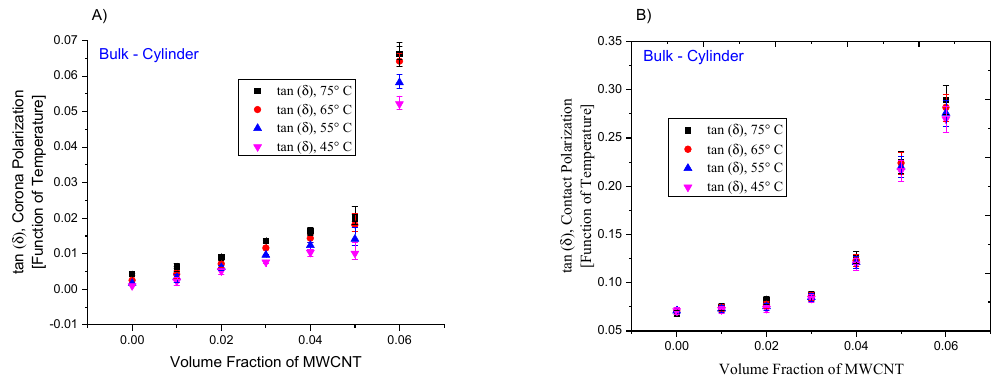
Figure 5. Variation in the dielectric constant as a function of temperature, volume fraction of MWCNTs, for ( A ) corona and ( B ) contact polarization techniques for bulk/disk samples.